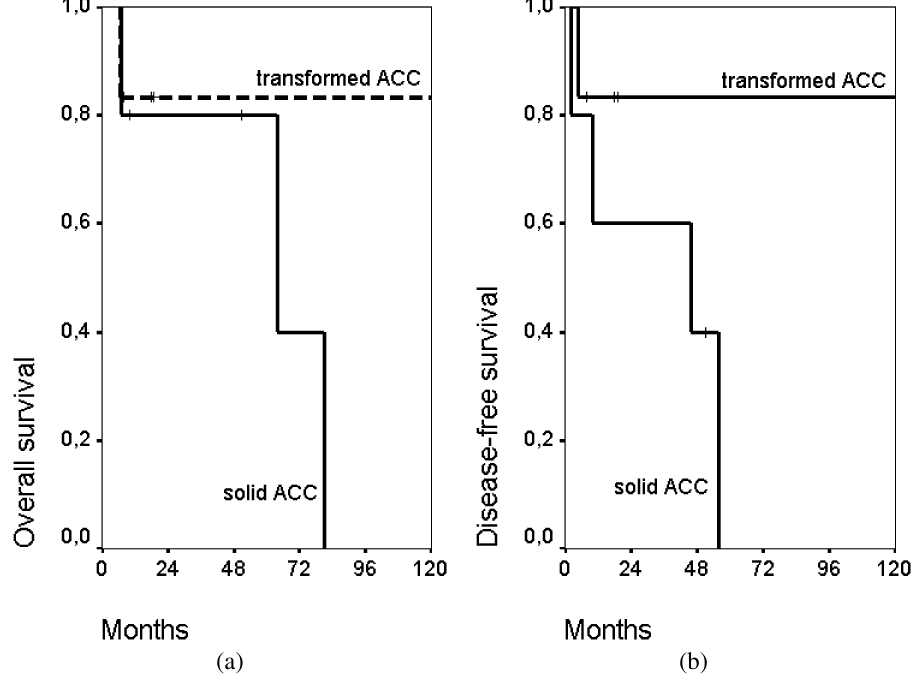
Fig. 3. (a) Kaplan–Meier curve showing the overall survival of 6 cases ACC-HGT versus 5 cases solid ACC. (b) Kaplan–Meier curve showing the disease-free survival of 6 cases ACC-HGT versus 5 cases solid ACC.